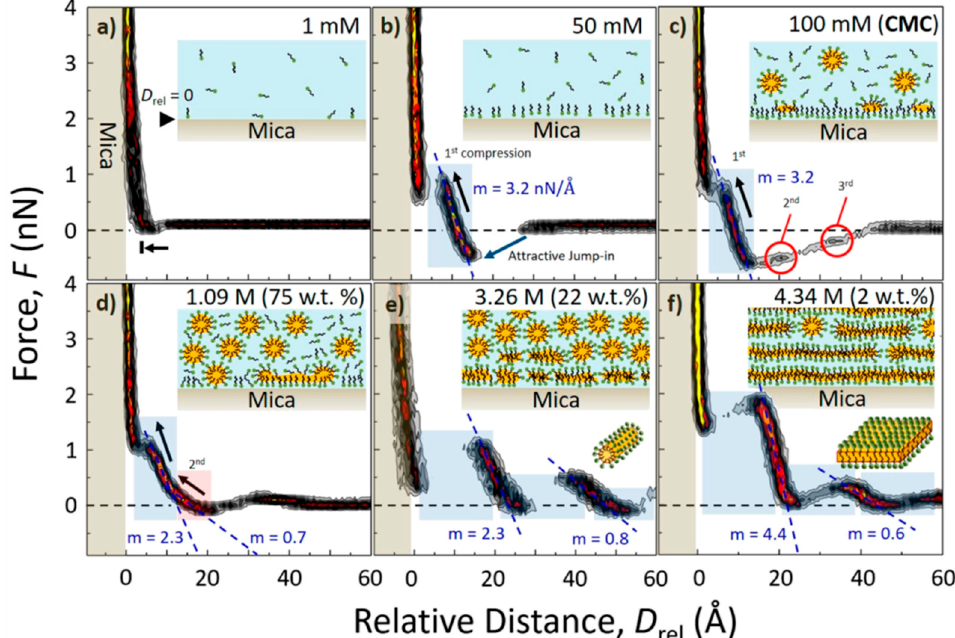
Figure 15. AFS investigation of the interface between mica and mixtures of water with different concentrations of [C 8 MIm][Cl]. The force/distance slopes (m) corresponding to the stiffness of each layer are shown as blue dotted lines and the schematic structural interpretations are depicted as insets. Adapted with permission from Cheng et al. [113]. Copyright 2018, American Chemical Society.